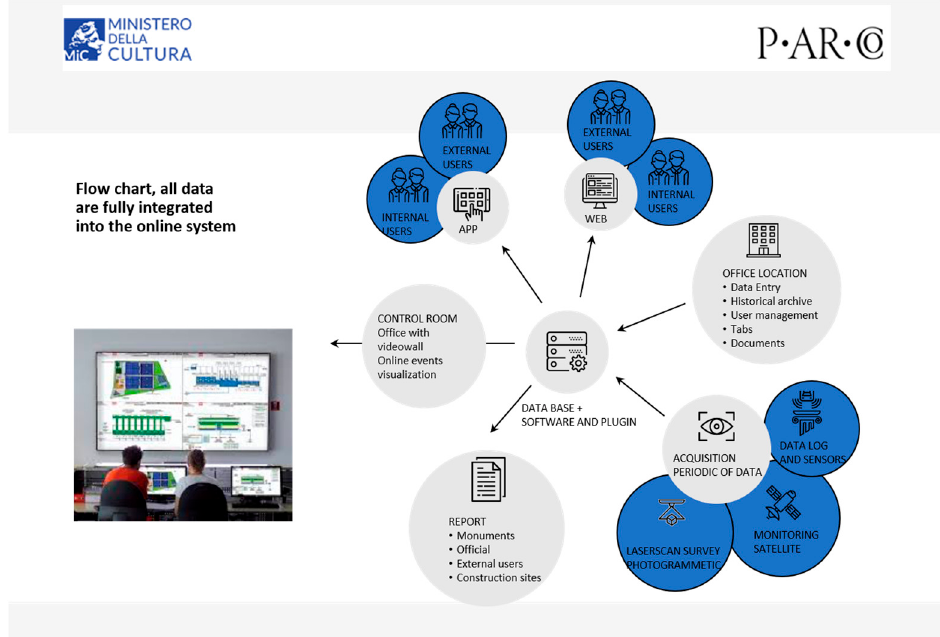
Figure 3. SyPEAH, monitoring lab: flow diagram in the WebAPP system.